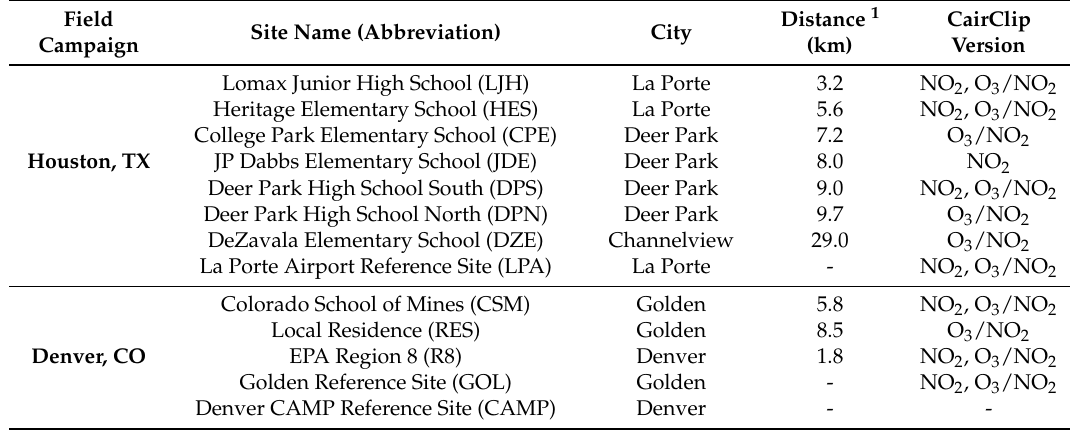
Figure 2. Map of the performance evaluation and citizen science sites in the Houston campaign. Table 1. Citizen science and reference measurement sites.